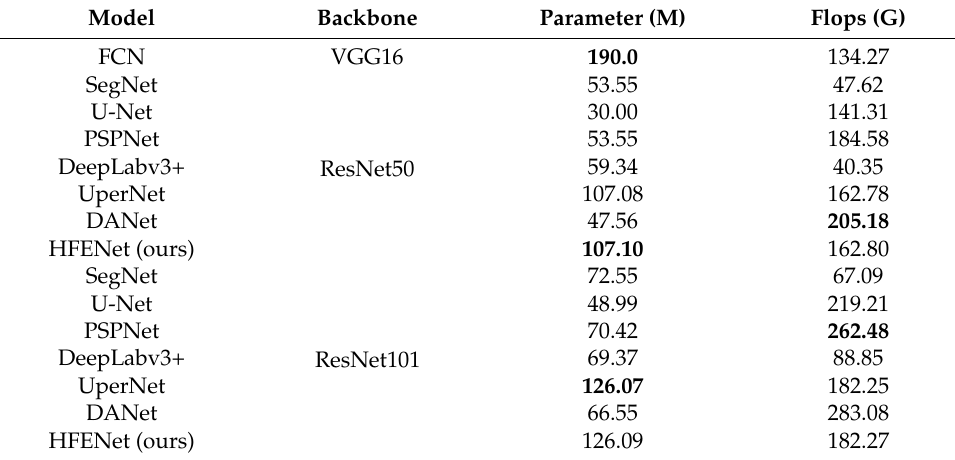
Table 9. The Parameter and Flops of each